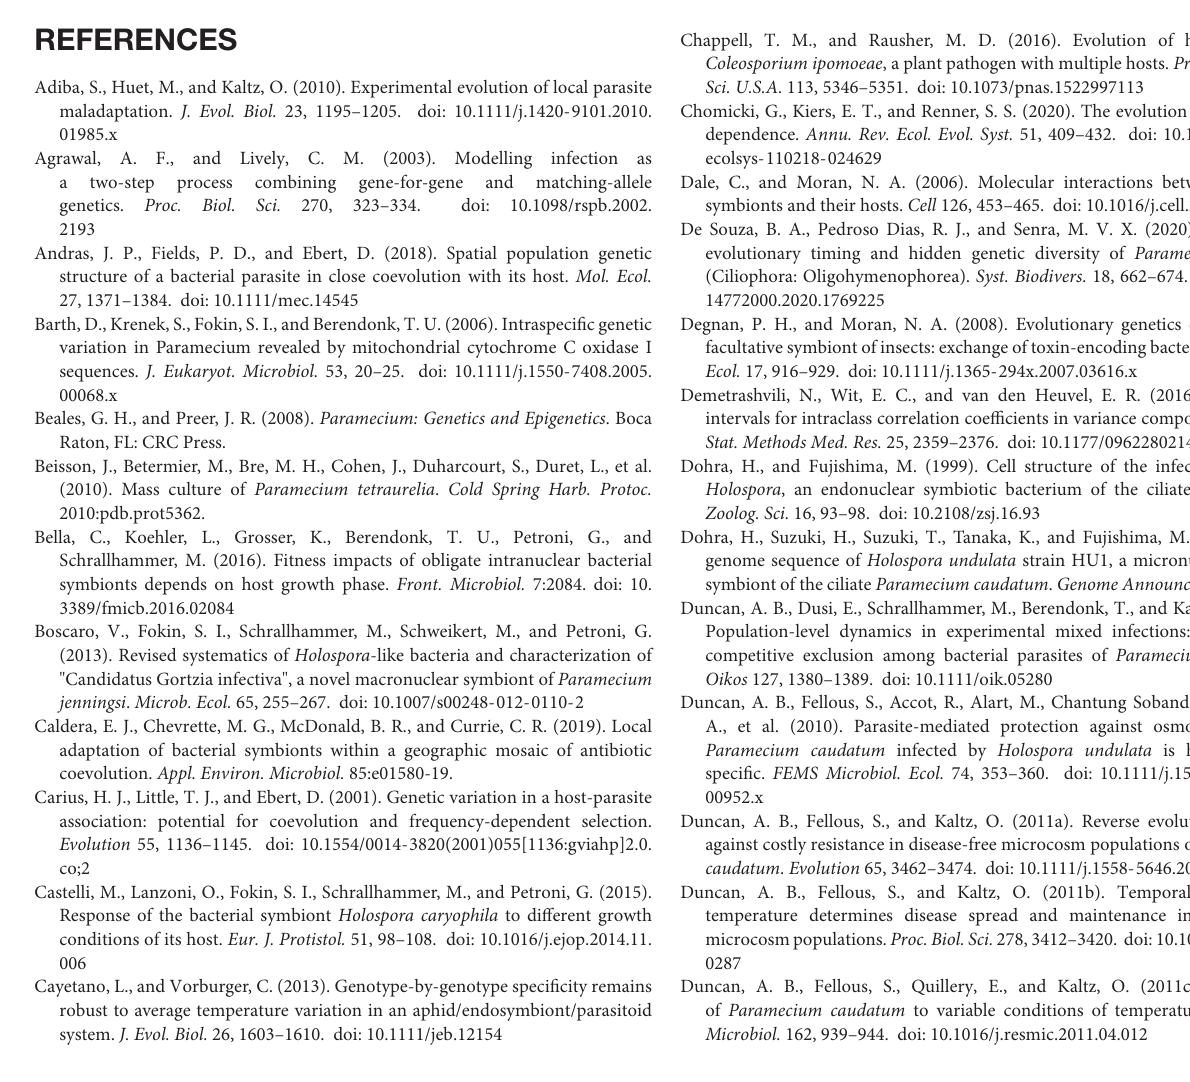
Supplementary Figure 2 | Correlations between geographic Euclidean distances and resistance differences (A) , pairwise genetic distances (based on neutral COI marker) and geographic Euclidean distances (B) , and pairwise resistance differences (C) , for 30 Paramecium caudatum strains confronted with the parasite Holospora undulata . Resistance differences based on the mean residual infection prevalences for each strain, after statistically correcting for laboratory and experimental block effects. Absolute values of pairwise differences were used for the correlation analysis. Each point refers to a different pair of strains. The 90% density ellipsoids represent a graphical indicator of the correlation between the two variables in each panel. Supplementary Table 1 | Information on the 30 Paramecium caudatum strains used in this study, including geographic origin and year of sampling, cytochrome oxidase 1 (COI) genotype and haplogroup, and the number of replicates tested in the resistance assays in the Bright (LB) and Kaltz (OK)